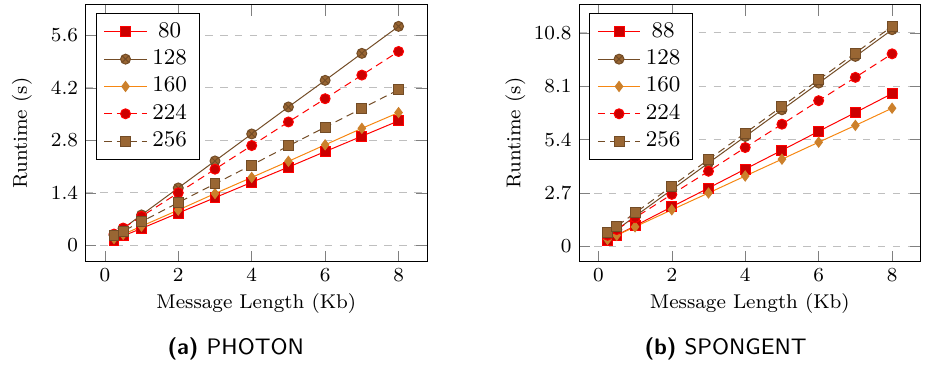
Figure 7: Runtimes of PHOTON and SPONGENT